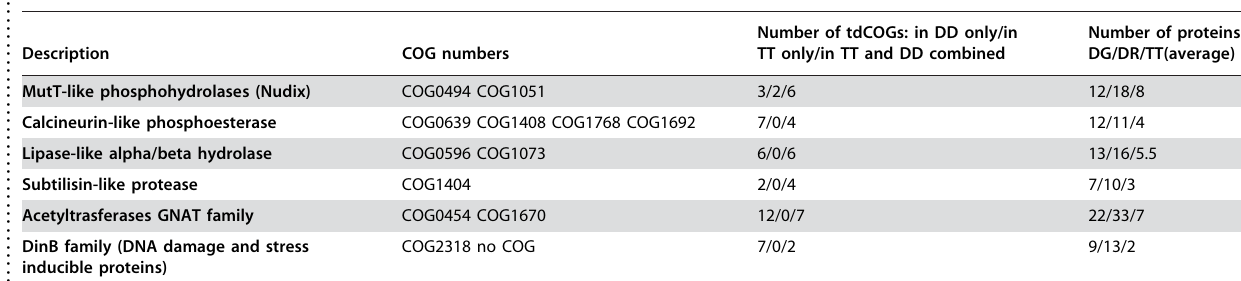
Table 2. Ancestral expansions: paralogous gene families expanded in the Deinococcus lineage (DD) versus the Thermus lineage (TT)